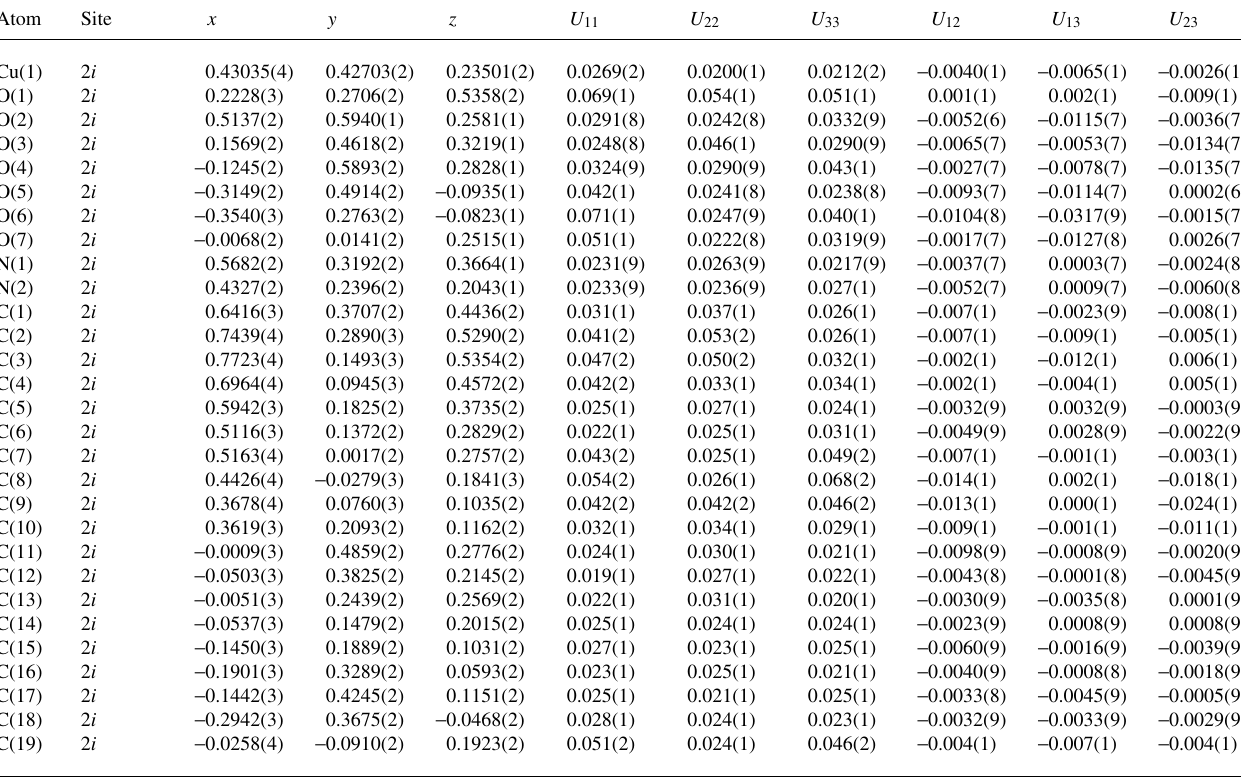
Table 3. Atomic coordinates and displacement parameters (in Å 2 ) .